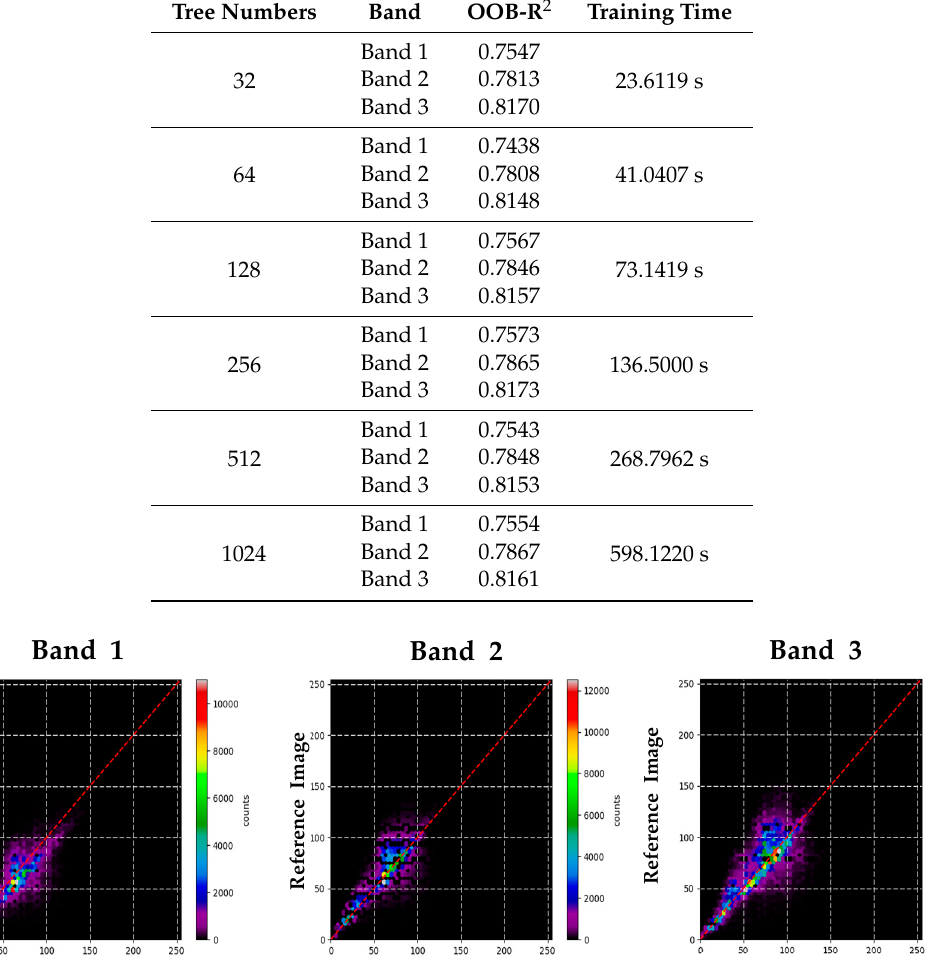
Table 3. OOB-R 2 and training time of RF regression.